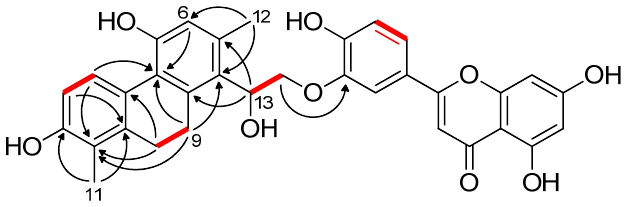
Figure 2. Key 1 H- 1 H COSY ( – ) and HMBC (H → C) correlations of ensifolin A ( 1